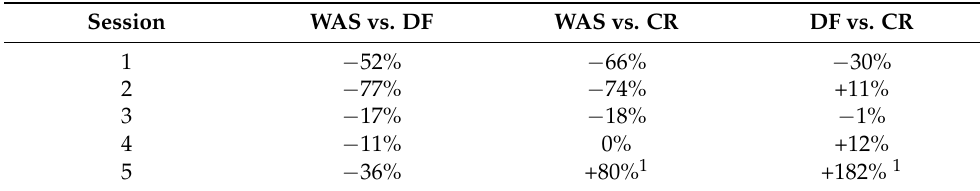
Table 5. Odor abatement efficiency comparison among the three rooms (WAS, DF and CR). WAS = Wet acid scrubber room; DF = dry filter room; CR = control room. WAS vs.